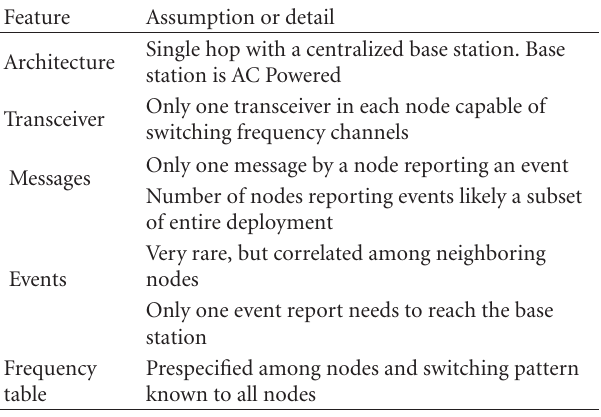
Table 1: Summary of features and assumptions of the Alert Protocol.